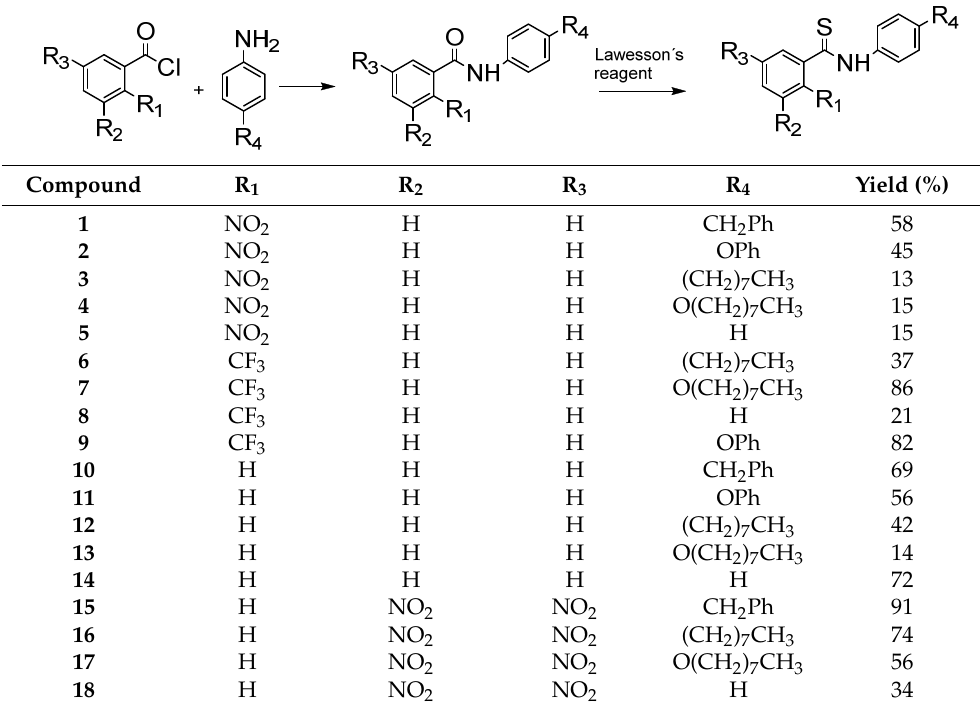
Table 1. Synthetic pathway and structure of thiobenzanilides 1 – 18 .